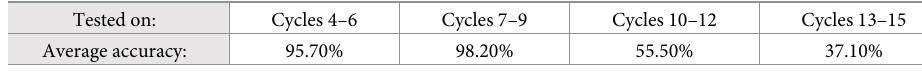
Table 9. Classification accuracies from training with the first three cycles.